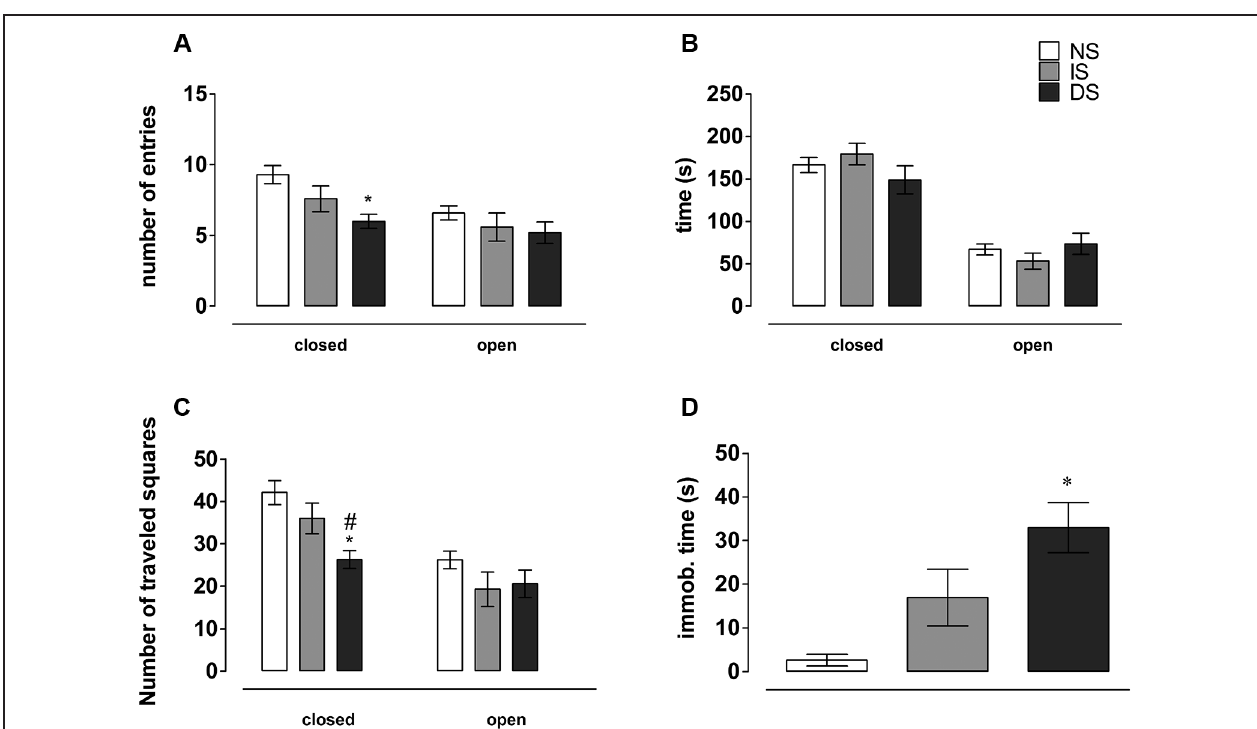
time on the EPM. NS = no-shock group ( n = 10); IS = immediate shock group ( n = 10); DS = delayed shock group ( n = 10). * p < 0.05 compared to NS group; # p < 0.05 compared to IS